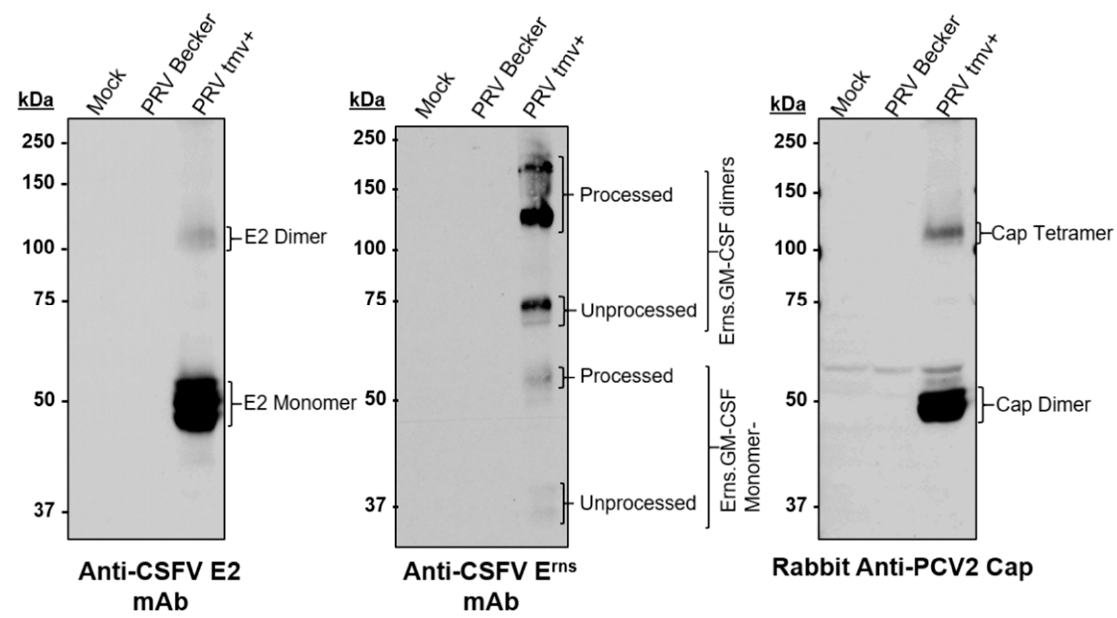
Figure 4. Immunoblot analysis of PRVtmv+ expressing chimeric CSFV E2, CSFV E rns -GM-CSF, and PCV2 cap proteins using an anti-CSFV E2 monoclonal antibody (mAbs) (left panel), an anti-CSFV E rns mAbs (middle panel), and a rabbit anti-PCV2 cap Ab (right panel), respectively. 3.1.2. PRVtmv+ Expressed PCV2b Cap Self-Assembles into Virus-like Particles (VLPs) In